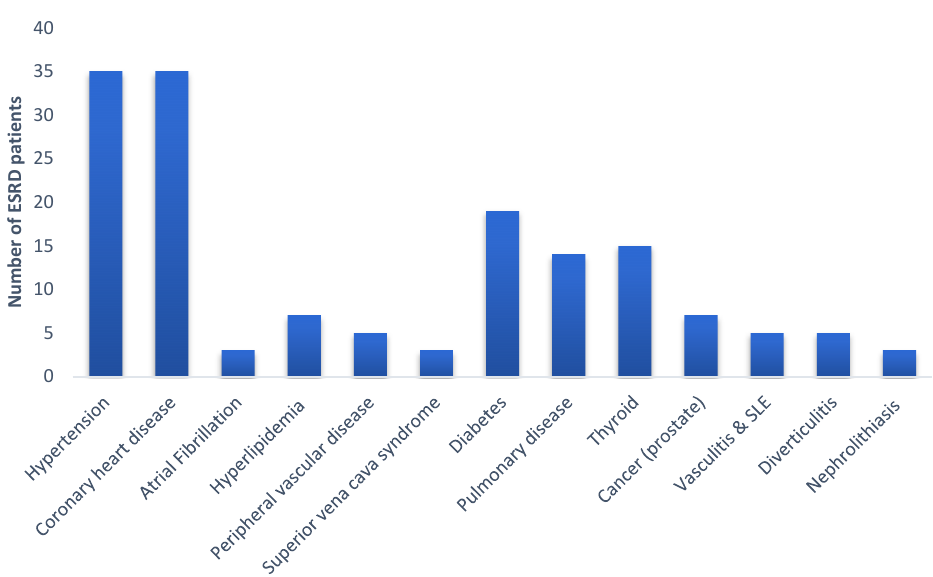
Figure 1. Comorbidities recorded among the ESRD patients of the study (ESRD: End Stage Renal Disease; SLE: Systemic Lupus Erythematous). Table 3. Demographic characteristics and lab test results of ESRD patients in the study .